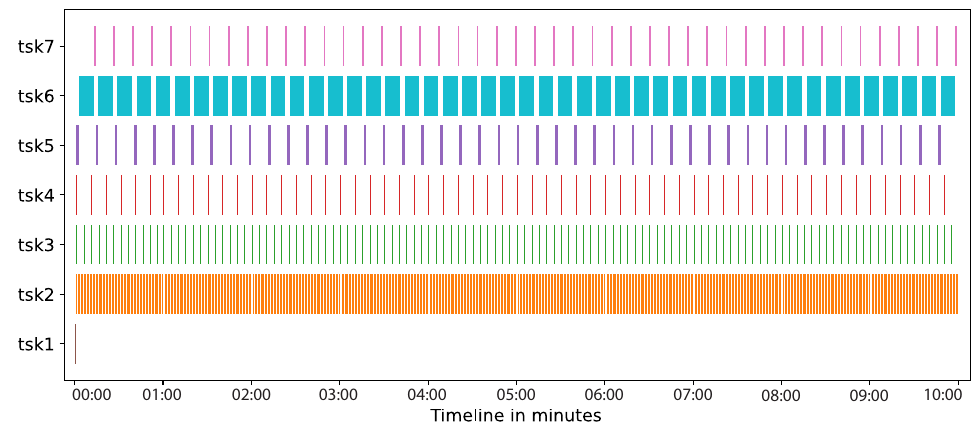
Figure 9. Time of tasks in the case